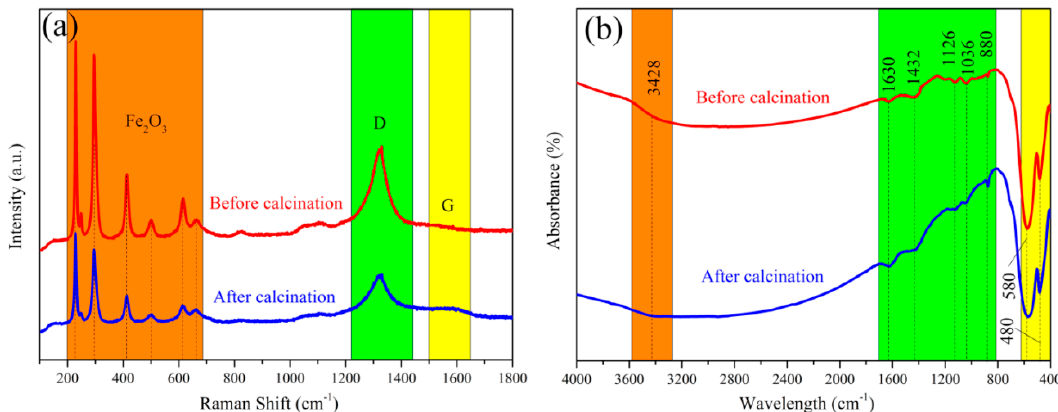
Figure 3. ( a ) Raman spectrums and ( b ) FTIR of α -Fe 2 O 3 @C nanoparticle composite before and after calcination.